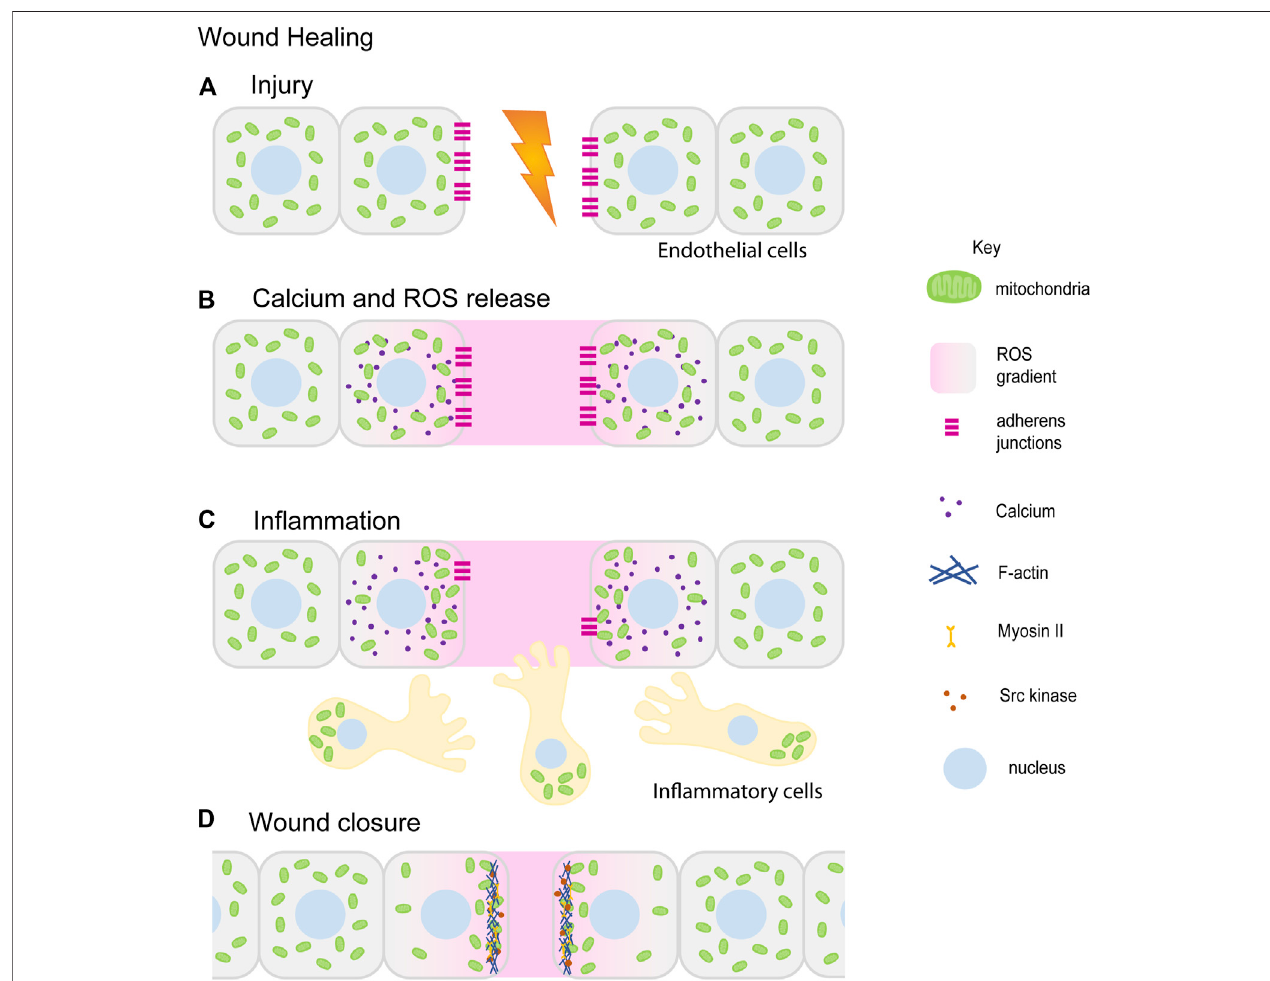
FIGURE 4 | Mitochondrial redistribution and function in wound healing. The schematic represents an overview of mitochondrial contribution in the series of events during the wound healing process. Upon injury, cells in the damaged tissue lose contact with each other forming a lesion in the tissue (A) . In response to the wounding, cytoplasmic calcium (purple) and ROS (pink) levels increase locally at the wound site ROS (pink) is also released extracellularly at the wound site (B) (Wright et al., 2008; Guo et al., 2017; Guo et al., 2020). Small, fragmented mitochondria (green) in cells adjacent to the wound site redistribute towards the wound site. In fl ammatory cells and immune cells (beige) migrate towards the wound site in response to ROS. Mitochondria (green) are localized at the uropods of these cells (C) (Campello et al., 2006;Morlinoetal.,2014).Thisisfollowedbytissuemorphogenesisandclosureaidedbyincreasedactomyosin(blue – Actin,yellow – Myosin)basedconstrictionandloss of E-cadherin (magenta) (C,D) (Fu et al., 2020; Ponte et al., 2020). Only a few of the references that have led to the fi gure compilation have been cited here.